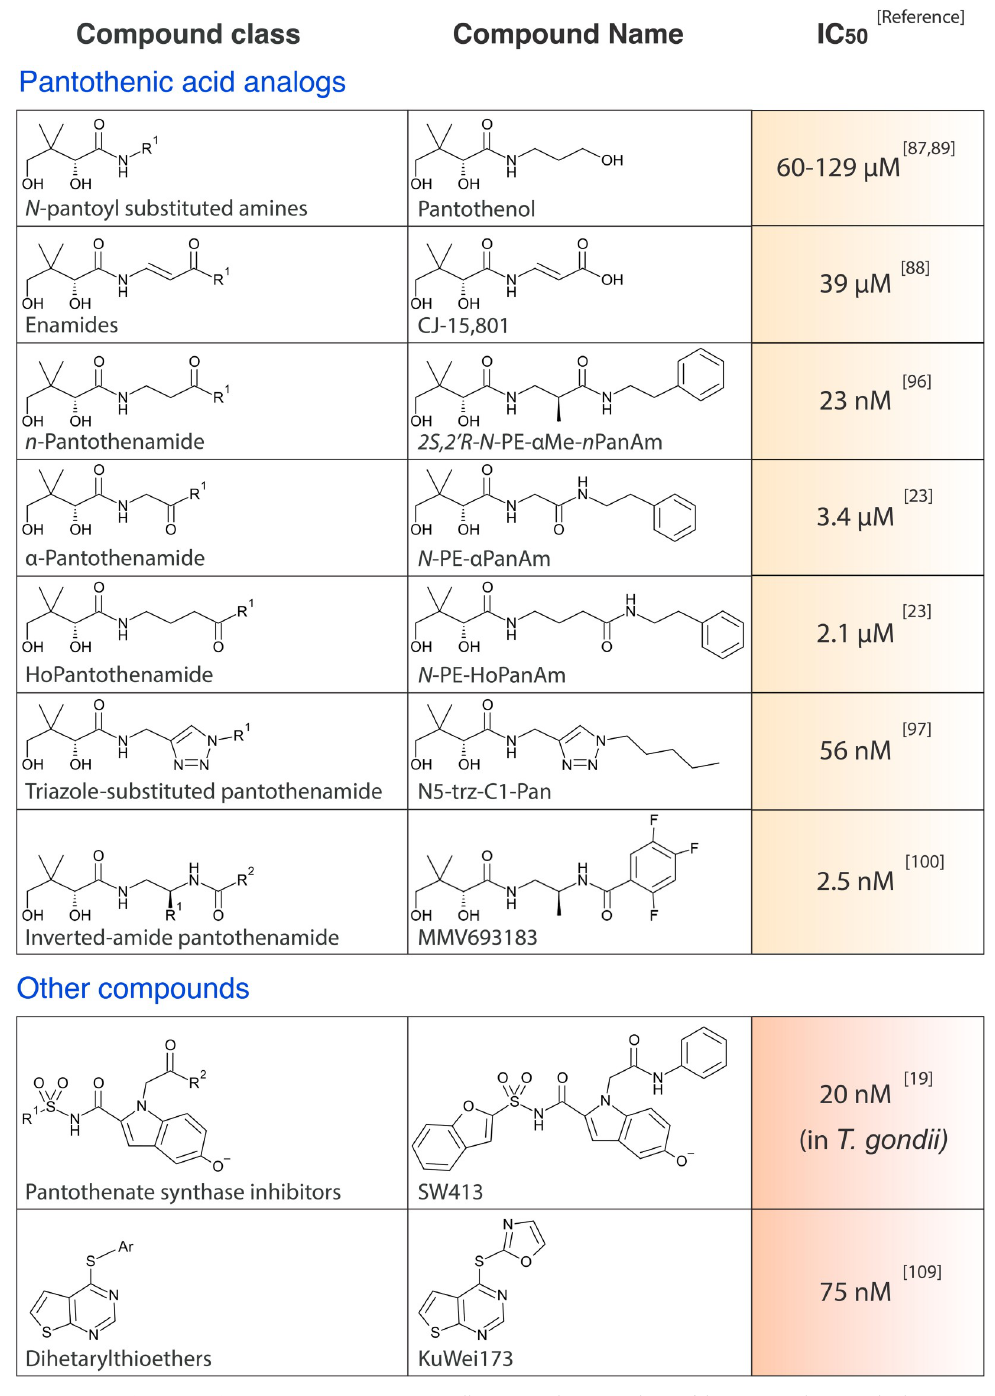
Fig 3. Pan and CoA synthesis targeting compounds. All IC 50 s are determined in P . falciparum , unless stated otherwise. CoA, coenzyme A; Pan, pantothenate. The dispensability of PPCS in Plasmodium and PPCDC in rodent malaria parasites pre- cludes these 2 enzymes as ideal drug targets [21,22,50]. In contrast, the bifunctional CoaBC enzyme (with both PPCS and PPCDC function) in M . tuberculosis is a potential drug target